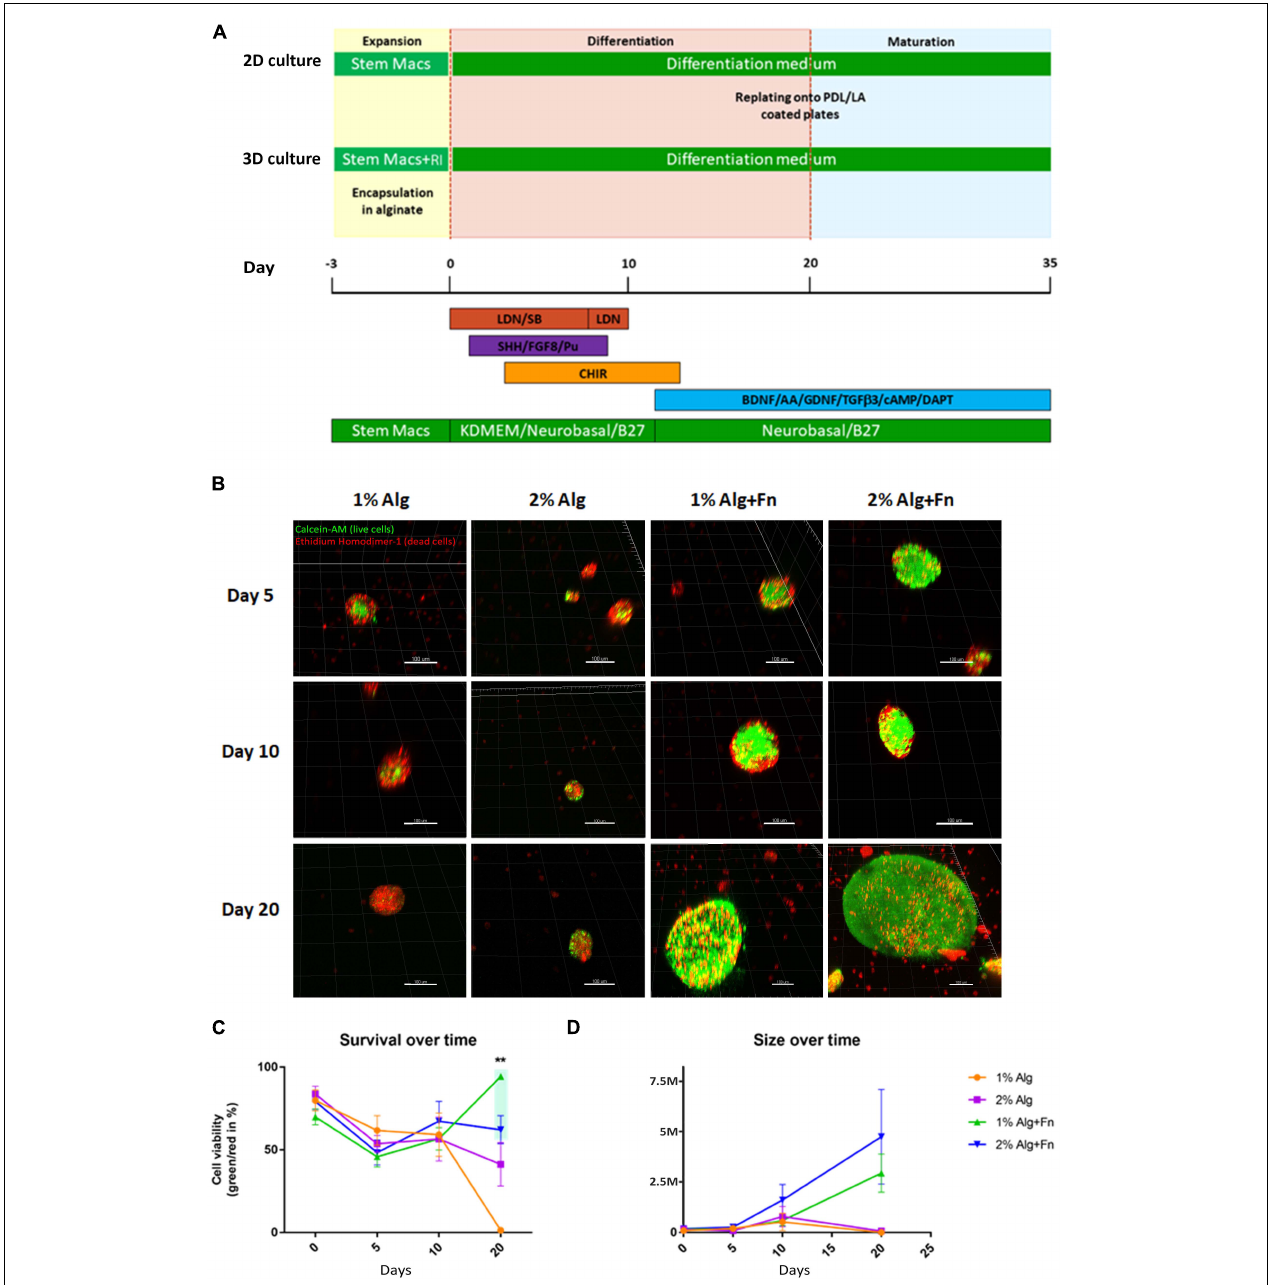
FIGURE 1 | Viability of hiPSCs encapsulated and differentiated in alginate of different compositions. (A) The induction of early neuroectoderm differentiation from hiPSCs was achieved by dual SMAD inhibition, followed by the activation of SHH, Wnt, and FGF8 signaling pathways for patterning the midbrain fate. The committed neural progenitor cells were terminally differentiated into DA neurons by withdrawal of key neurogenic factors (BAGTCD). SM, StemMACS medium; RI, Rho associated kinase inhibitor; BAGTCD, BDNF, L-Ascorbic Acid, GDNF, TGF β 3, dbcAMP, DAPT. (B) Representative 3D reconstructions of cell aggregates stained with Calcein-AM (green, live cells) and Ethidium Homodimer-1 (red, dead cells). Scale bar represents 100 µ m. (C) Cell viability over time was calculated as a percentage of green/red ratio. (D) Average size of the cell aggregates formed by viable cells was measured in millions of cubic micrometers. Statistical differences were calculated by two-way ANOVA followed by Tukey’s post hoc test to correct for multiple comparisons ** p ≤ 0.005.